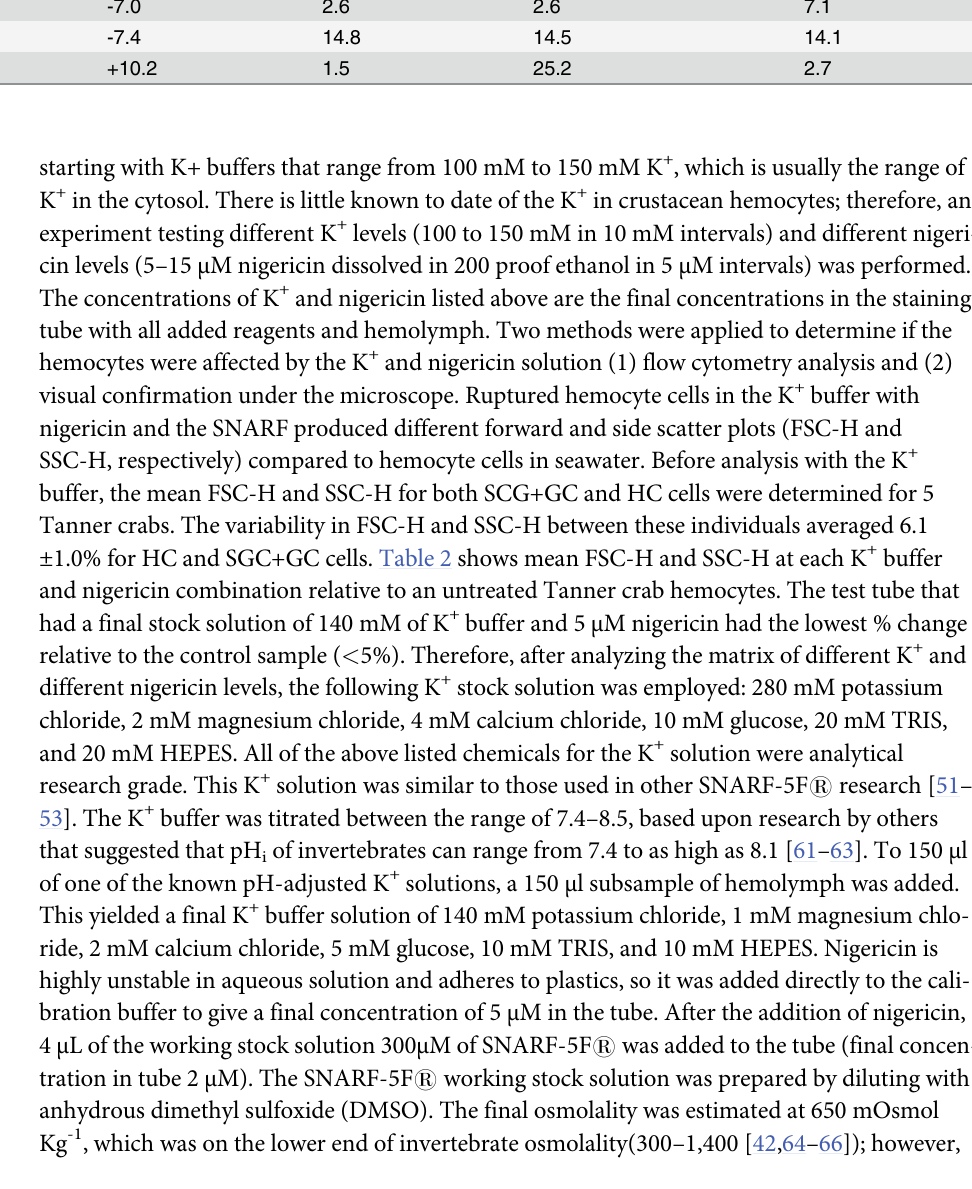
Table 2. The percent change of the mean FSC-H and SSC-H for both hyalinocyte cells (HC) and semi-granular+granular cells (SGC+GC) relative to a sample of hemocytes without the potassium buffer, nigericin, or SNARF from Tanner crab ( Chionoecetes bairdi) . The potassium and nigericin con- centrations listed are the final concentrations in the test tube after all the reagents and hemolymph were added. Potassium